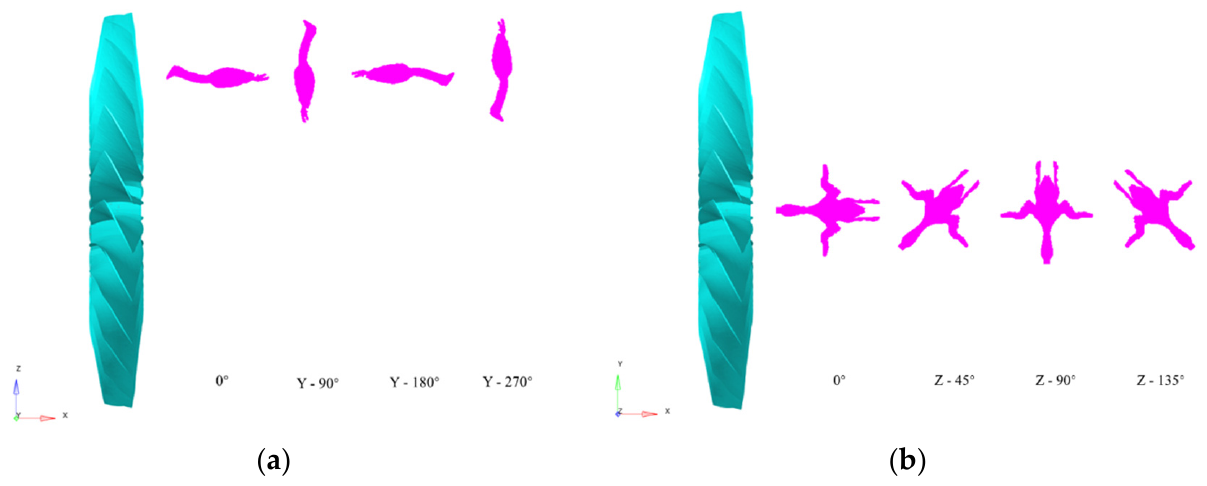
Figure 7. Different impact orientations of the bird resulting from rotating the bird model around the ( a ) Y axis and ( b ) Z axis.